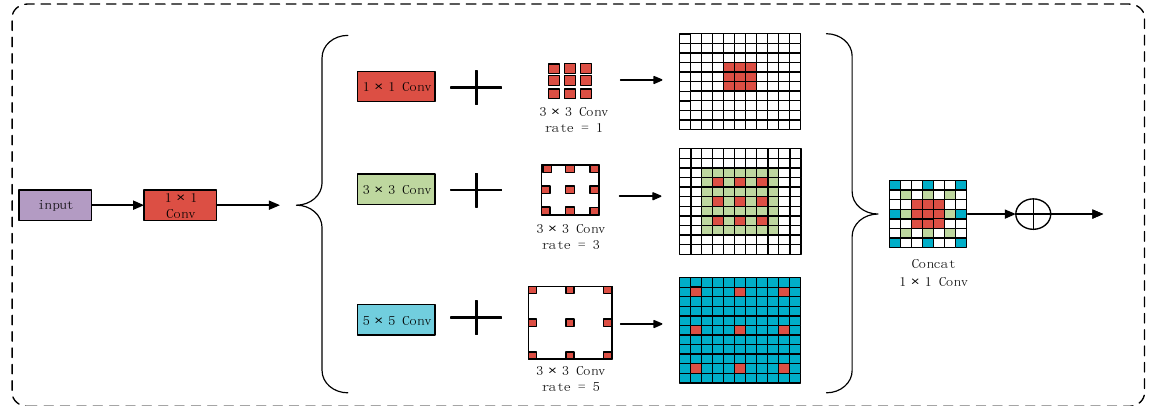
Figure 2. Receptive field block.